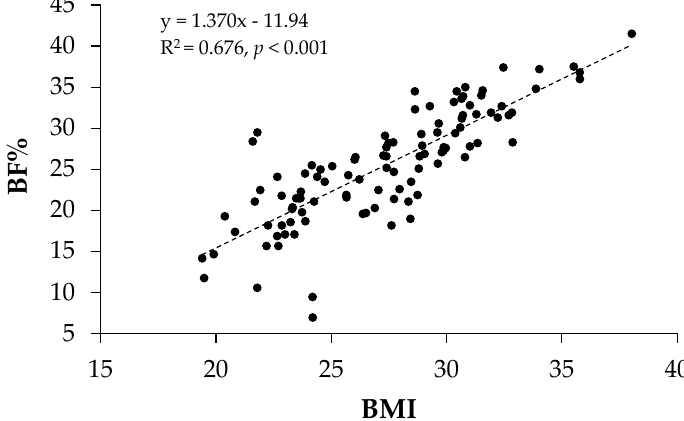
Figure 1. The relationship between body fat % (BF%) and body mass index (BMI) in submariners. BF% and BMI were significantly correlated, r = 0.822, p < 0.001 ( n = 106).